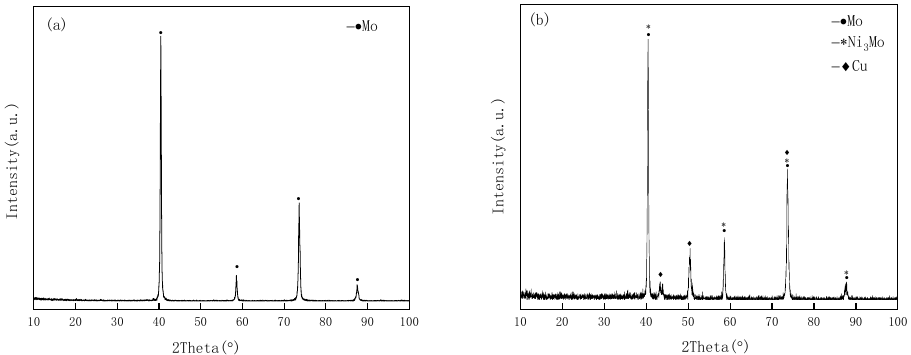
Table 1. Point energy spectrum analysis results for different areas of the cladding layer (at.%).